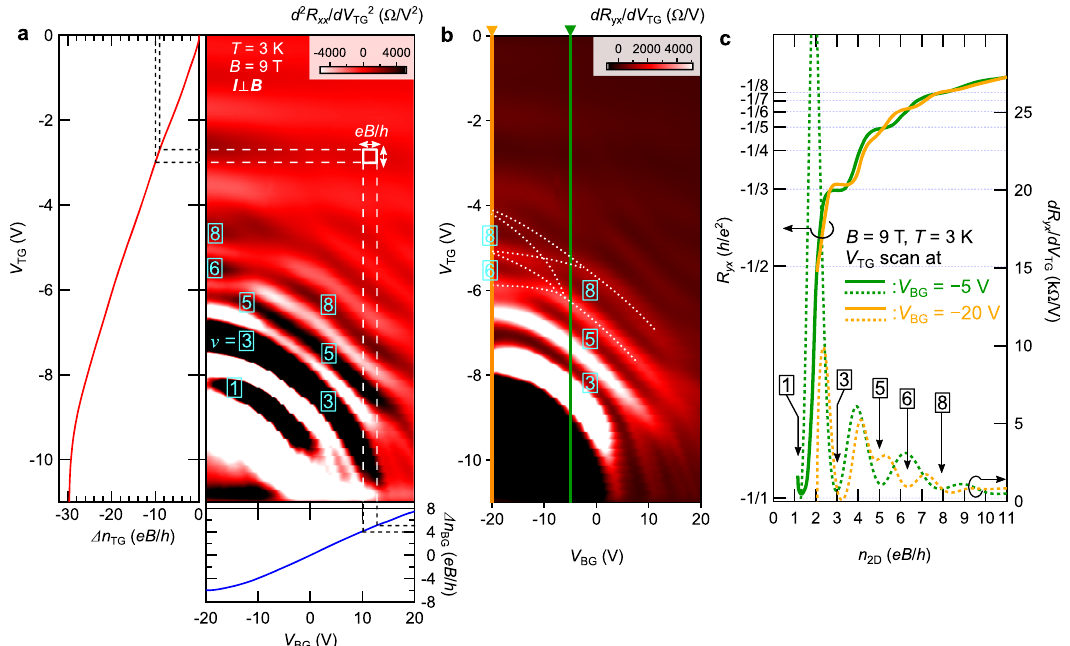
Fig. 3 Dual-gate modulation of the surface quantum Hall states. a , b Mappings of second derivative of resistance R xx ( a ) and fi rst derivative of Hall resistance R yx ( b ) as a function of V TG and V BG . The modulation of the sheet electron densities ( Δ n TG , Δ n BG ) in the V TG and V TG scans are also shown in a . The quantum Hall state of each fi lling factor ν exhibits a stripe pattern over a wide range of carrier density, indicating the concomitant modulation of the paired Weyl orbits by both the top- and back-gating. Overlaid dashed lines in b show the fi ne structure of the Landau level crossings caused by the degeneracy lifting of the two Weyl orbits. c V TG scans of R yx and its fi rst derivative (along the vertical lines at V BG = − 5 and − 20 V shown in b plotted as a function of sheet electron density n 2D . The n 2D axis is presented in units of the Landau level degeneracy eB / h